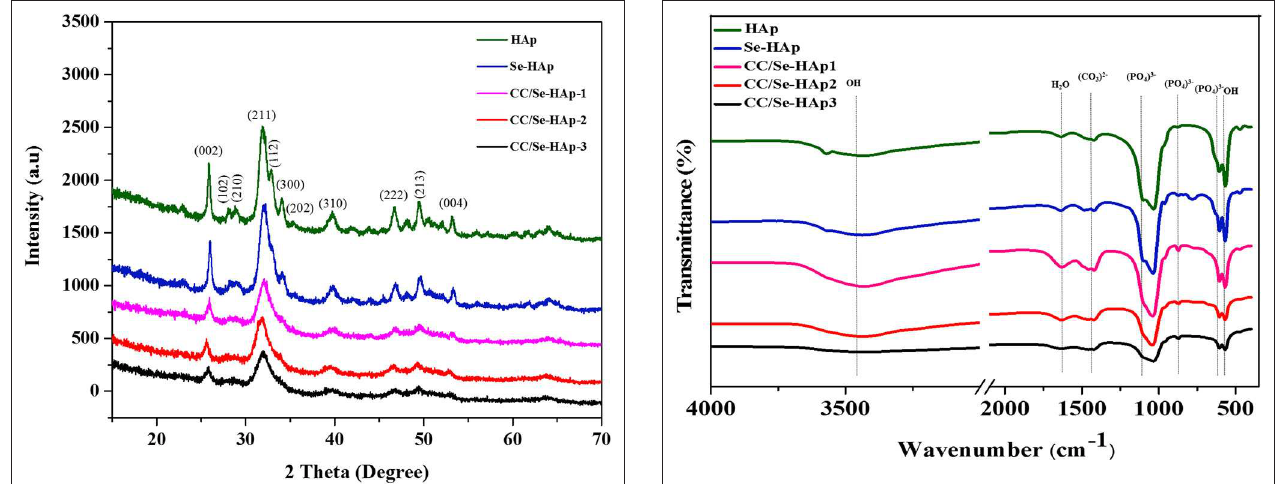
FIGURE 1 | X-ray diffraction spectra of pristine HAp nanoparticles, and selenium-doped hydroxyapatite (Se-HAp), and modification of Se-HAp composites with different concentrations of catechins, i.e., 5% (CC/Se-HAp1), 7% (CC/Se-HAp2), and 10% (CC/Se-HAp3). The patterns of XRD depicted that both HAp and Se-HAp presented the typical HAp peaks, with the no significant differences. The peak (211) associated CC/Se-HAp showed a reduction in crystallinity which determines the association of catechin contents.